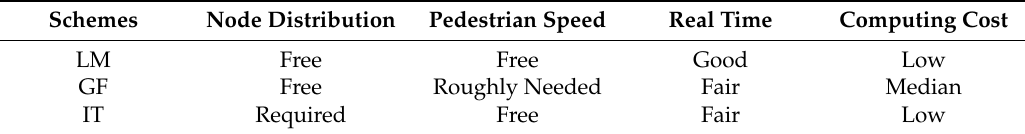
Table 2. Practicability analysis of the GT-based passive tracking